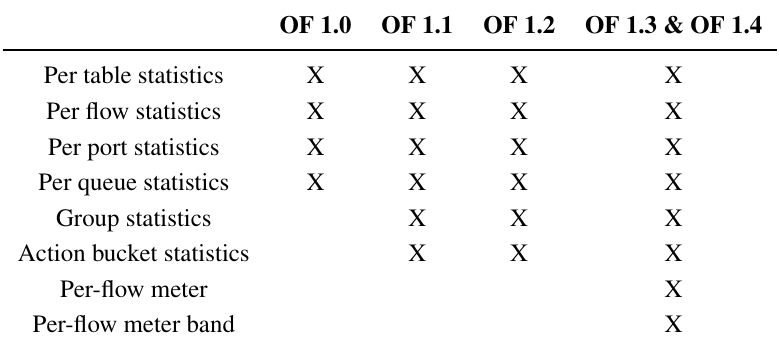
Table 3. Statistics are measured for different parts of the OpenFlow switch.